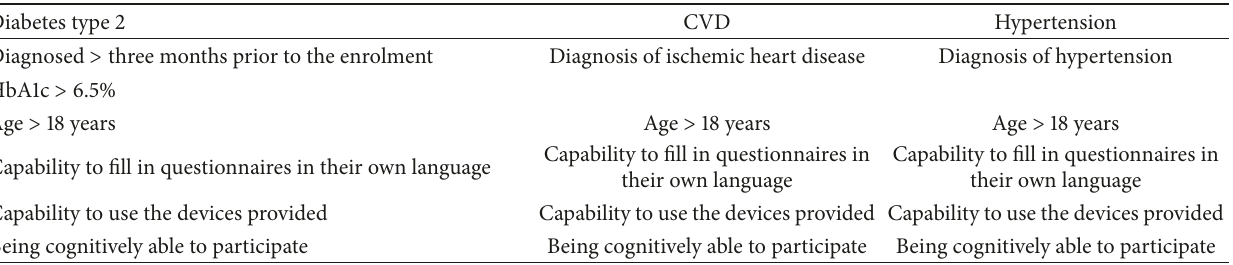
Table 1: Inclusion